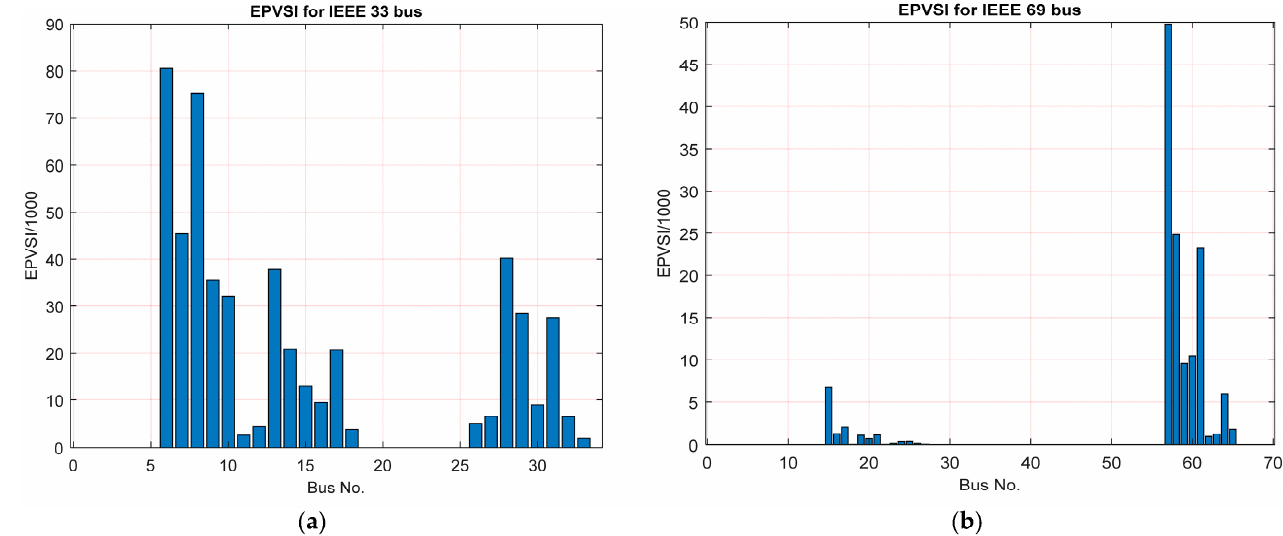
Figure 11. EPVSI values for IEEE ( a ) 33-bus ( b ) 69-bus RDNs.